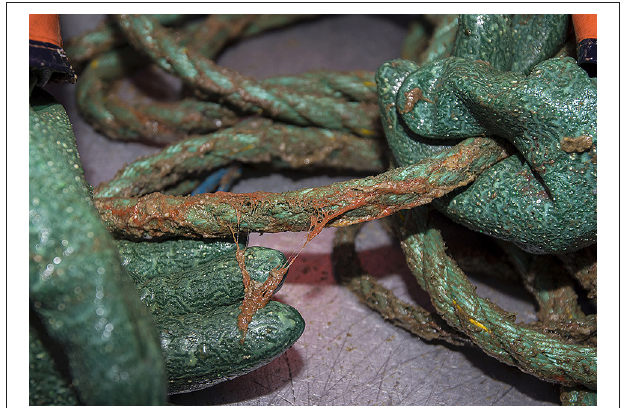
FIGURE 2 | A net rope heavily contaminated with the red “slime” documented by a fisherman from Arnøya, northern Norway. See Figure 1 for location of